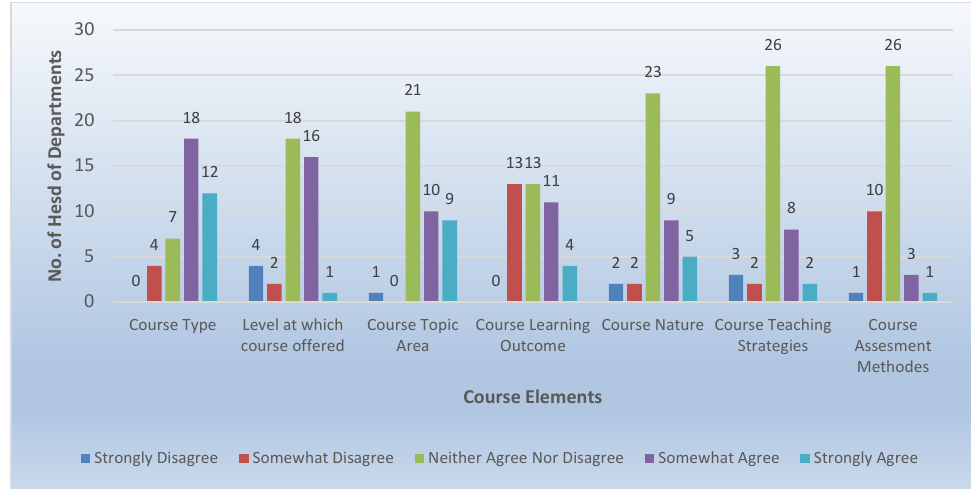
Figure 9. Comparing course elements.